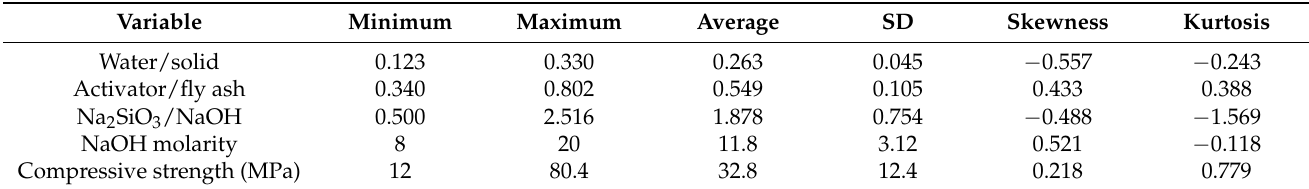
Table 2. Statistics for input and target